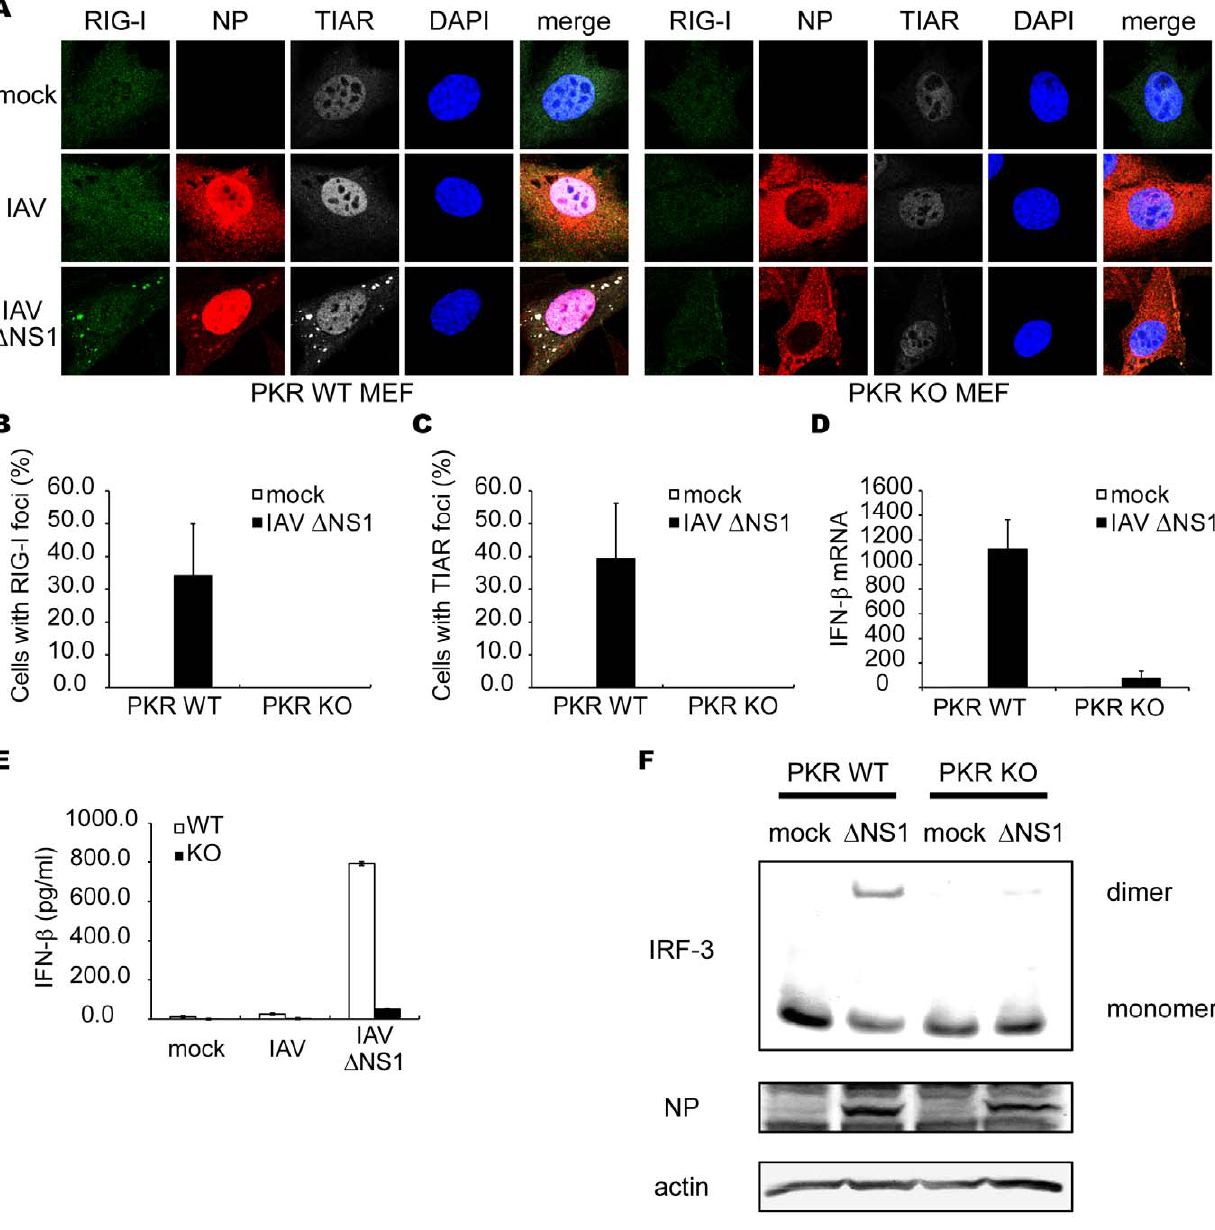
Figure 6. Critical role of PKR in formation of avSG and IFN-aˆ gene activation. ( A–C ) MEFs derived from WT and PKR KO mice were mock- treated or infected with IAVA¨NS1 for 12 h. The cells were stained with anti-RIG-I, anti-IAV NP and anti-TIAR antibodies and DAPI ( A ). The percentage of cells containing foci of RIG-I ( B ) or TIAR ( C ) was determined. ( D–F ) PKR WT and PKR KO MEFs were mock-treated or infected with IAVA¨NS1. The IFN- aˆ mRNA level at 9 h post-infection was determined by qPCR ( D ). The IFN-aˆ protein levels in culture medium at 15 h post-infection were quantified by ELISA ( E ) . Cell extracts were subjected to Native-PAGE and IRF-3 dimer was detected by immunoblotting using anti-IRF-3 antibody. IAV NP and actin were detected by SDS-PAGE followed by blotting using anti-NP and anti-actin antibodies ( F ). Data shown in B-E are represented as the mean standard 6 error of the mean (SEM).